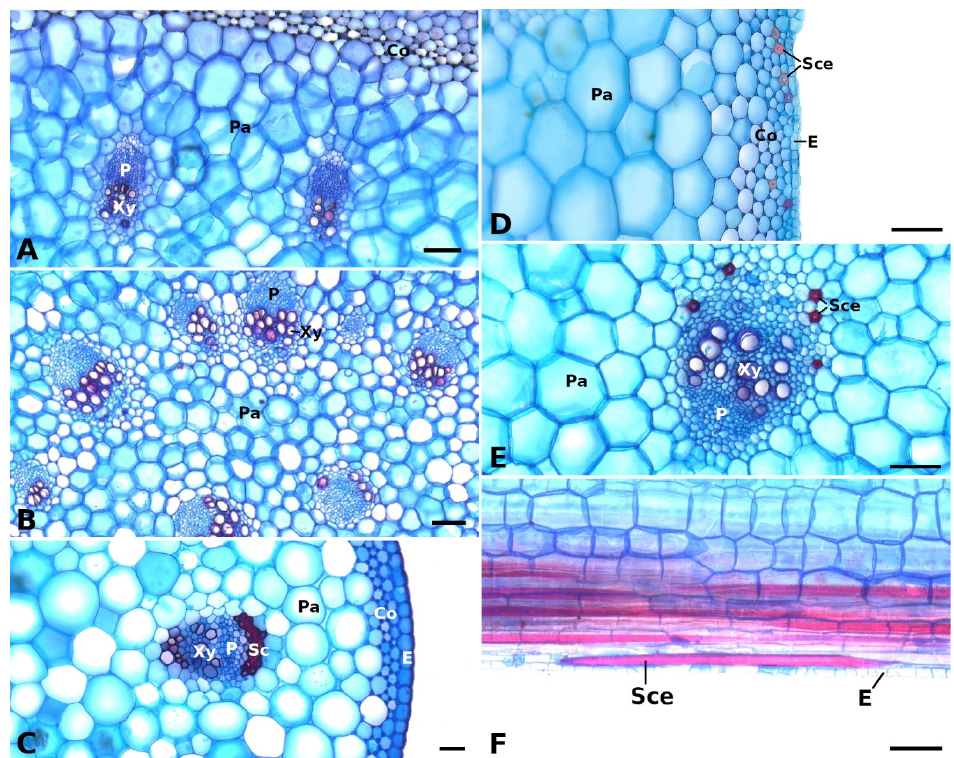
Figure 2. Vascular bundles and strengthening tissues in the petioles of Begonia glabra ( A ), B. egregia ( B ), B. amphioxus ( C ), and B. sudjanae ( D – F ). The cross sections ( A – E ) show vascular bundles with epidermis (E), phloem (P), and xylem (Xy) embedded in parenchyma (Pa), subepidermal collenchyma (Co) layers, sclerenchyma caps (Sc), and sclereid cells (Sce). In the petiole of B. sudjanae elongated sclereids cells (Sce) can be found ( F , longitudinal section). Staining: astrablue/safranin, scale: 100 µ m. All samples were taken from one plant per species (two for B. sudjanae